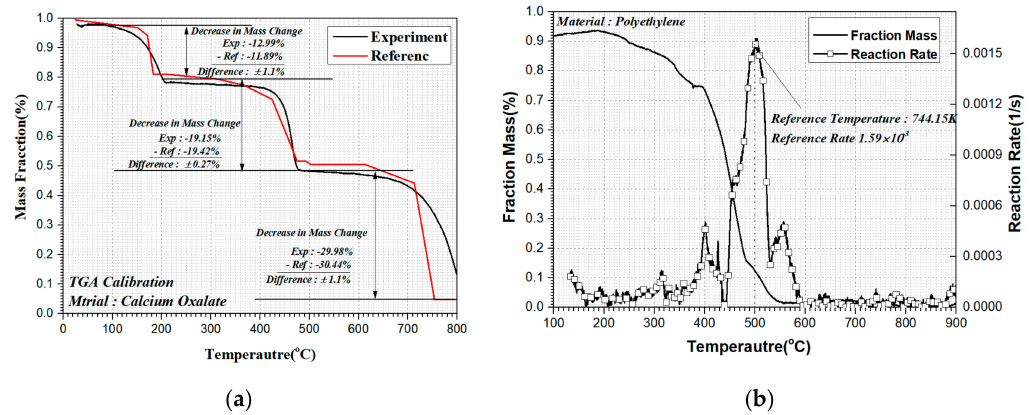
Figure 4. ( a ) Calibration results of TGA using calcium oxalate and ( b ) the results of TGA for material properties of the test sample (polyethylene